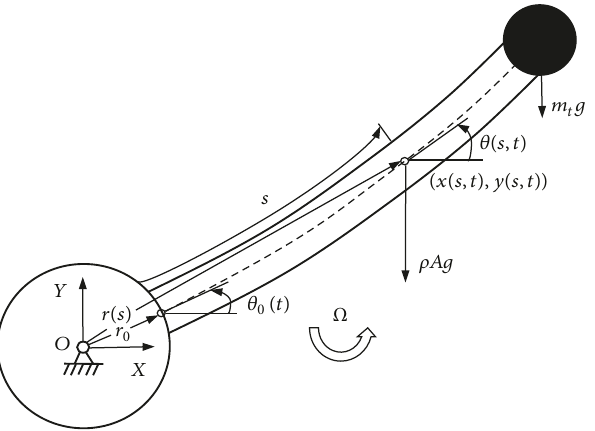
Figure 1: Configuration of a rotating hub-beam system with a tip